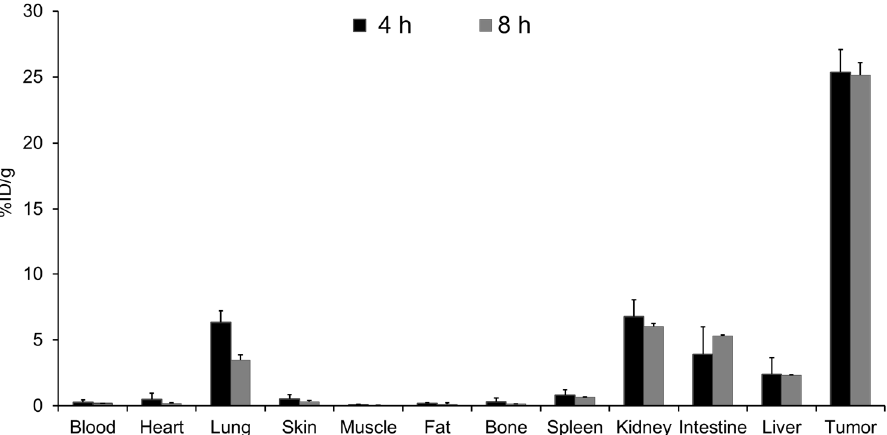
Figure 6. Biodistribution data of pretargeting strategy at 48 h post-injection of hnRNP conjugate in female nude mice bearing MDA-MB-231 tumor xenografts. Organs were harvested at 4 and 8 h after the administration of 64 Cu-PCB-TE2A-Tz.